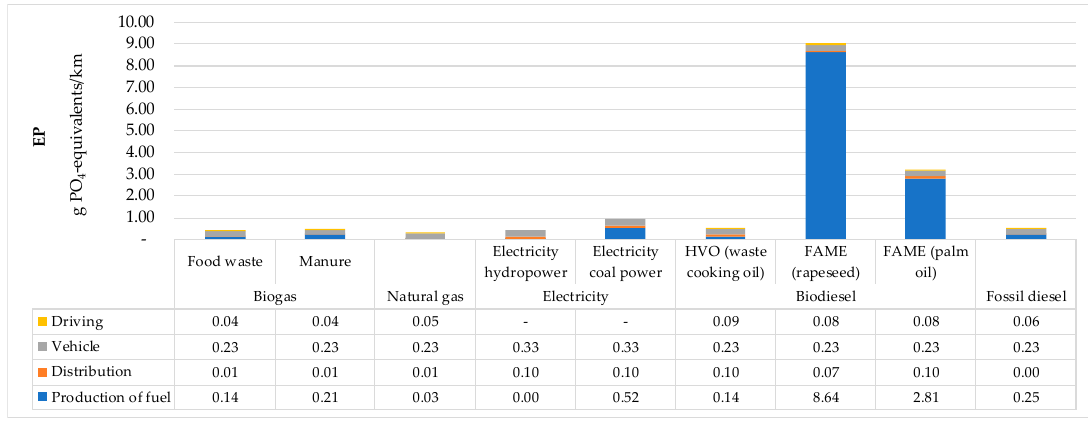
Figure 1. Results from the LCA of the fuel alternatives: ( a ) Global warming potential (GWP); ( b ) stratospheric ozone depletion potential (ODP); ( c ) photochemical oxidant formation potential (POCP); ( d ) acidification potential (AP); and ( e ) eutrophication potential (EP).